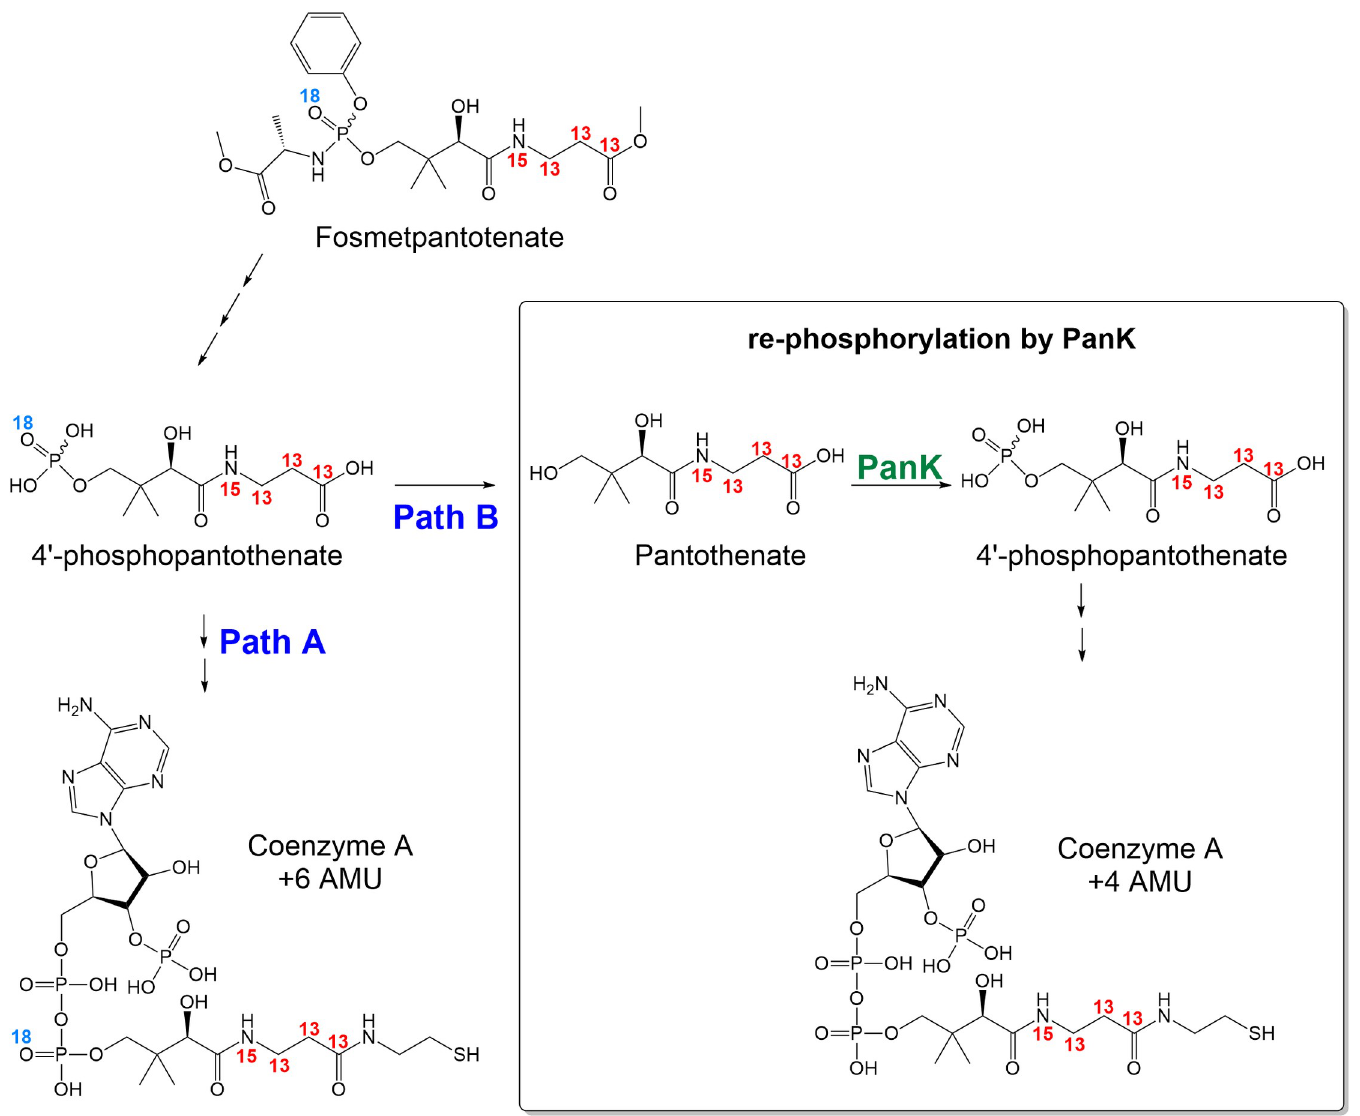
Fig 5. Formation of labelled-CoA species from labelled-fosmetpantotenate (+6 AMU).